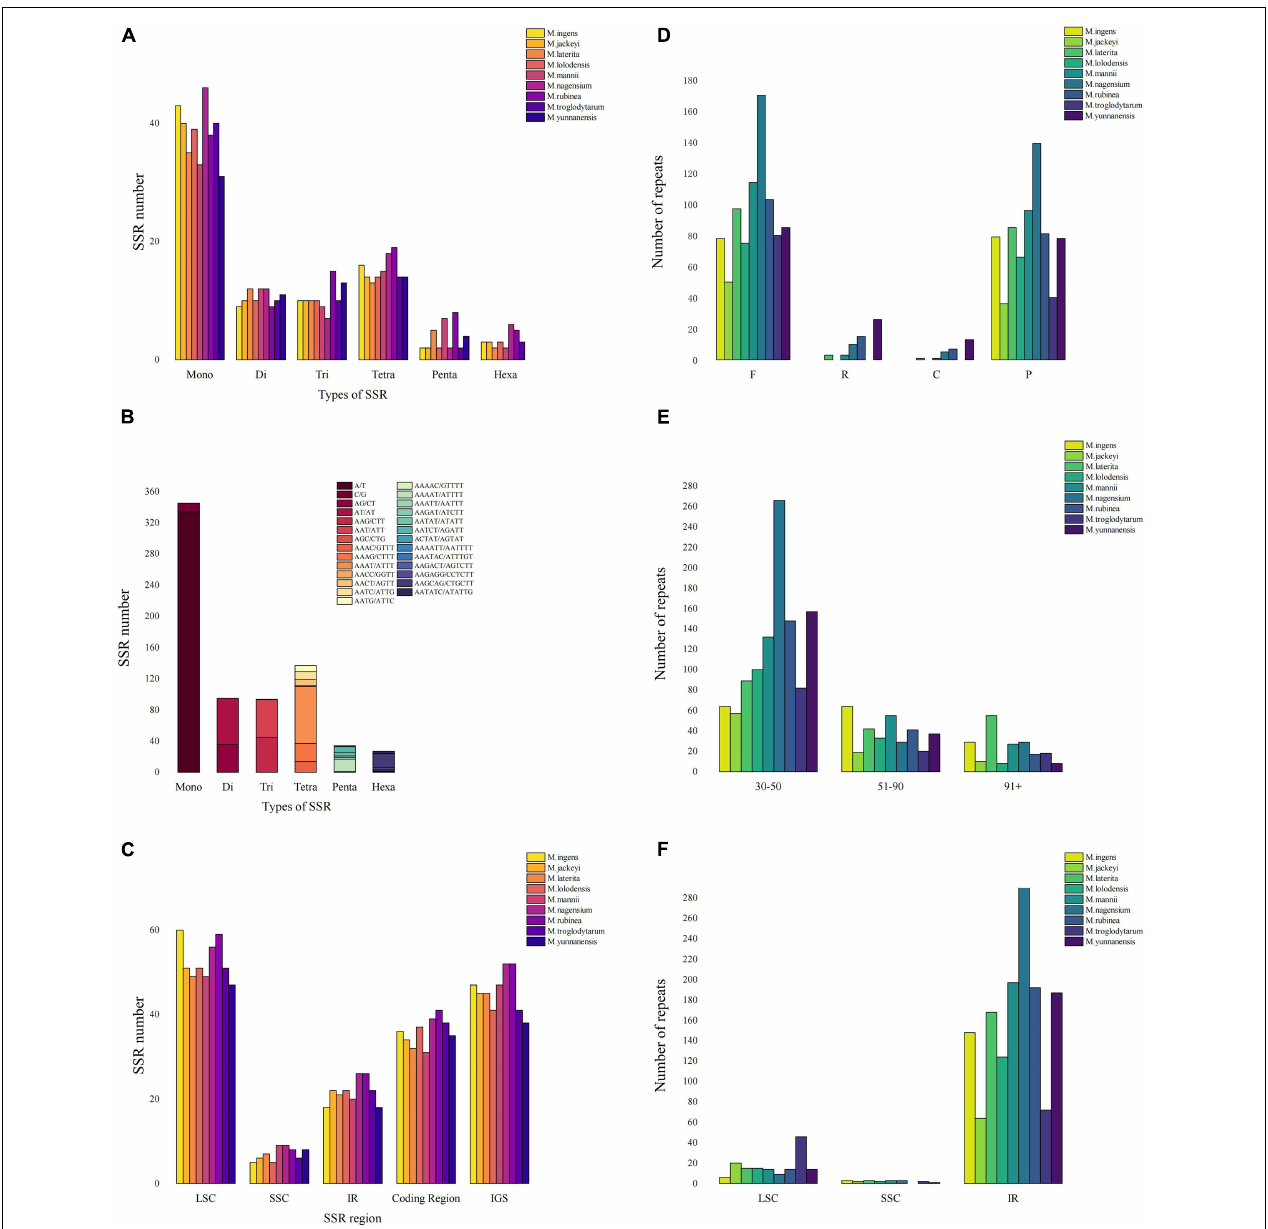
FIGURE 3 | Comparison of microsatellites and long repeats in the chloroplast genomes of Musa species. (A) The number of SSRs of different types of SSR for nine Musa species. (B) Details in SSR types among nine Musa species. (C) The number of SSR markers in the LSC/SSC/IR region along with coding region and IGS. (D) Number of four long repeat sequences in nine species: complement repeats. F represents forward repeats, P represents palindromic repeats, R represents reverse repeats, C represents complement repeats. (E) Number of long repeat sequences with different lengths in nine species. (F) The distribution of long repeats in LSC, SSC and IR